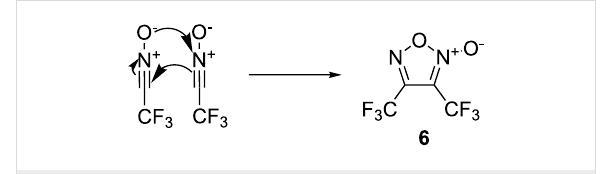
entry reaction conditions time